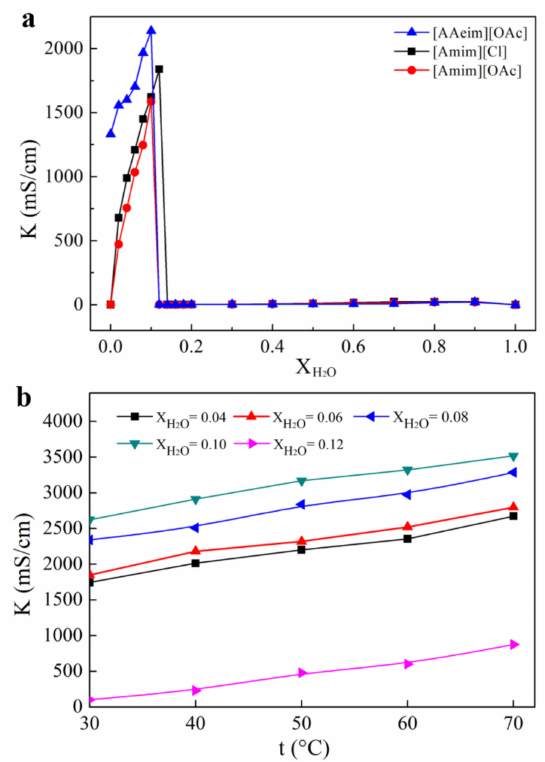
Figure 4. ( a ) The electric conductivities of 1,3-diallyl-2-ethylimidazolium acetate ([AAeim][OAc]), 1-allyl-3-methylimidazolium chloride ([Amim][Cl]) and 1-allyl-3-methylimidazolium acetate ([Amim][OAc]) with different water contents (weight percent of water in the mixture); ( b ) The electric conductivities of 1,3-diallyl-2-ethylimidazolium acetate with different levels of water content (0.04~0.12) and temperature (30~70 ◦